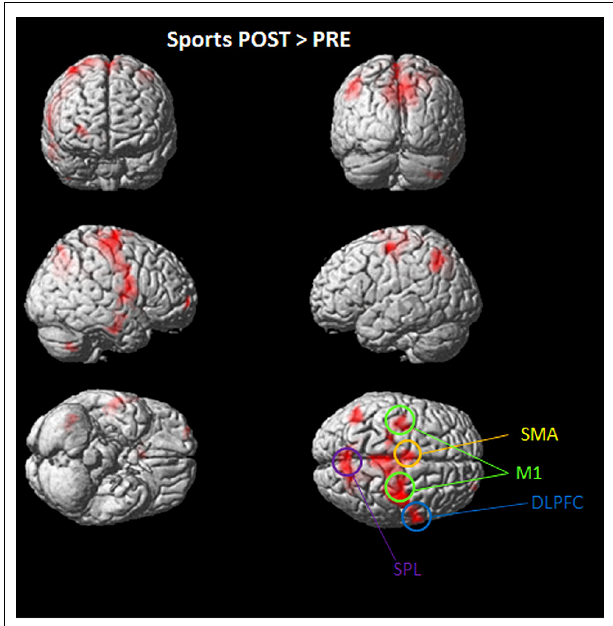
FIGURE 3 |Activated regions in direct comparisons “Sports POST > PRE” condition. All regional activations above initial significance threshold P < 0.05 (FEW corrected) and extent ( k E ) of 30 voxels are depicted on a rendered MNI brain. DLPFC = dorsolateral prefrontal cortex; SPL = superior parietal lobule; M1 = primary motor cortex; SMA = supplementary motor area.